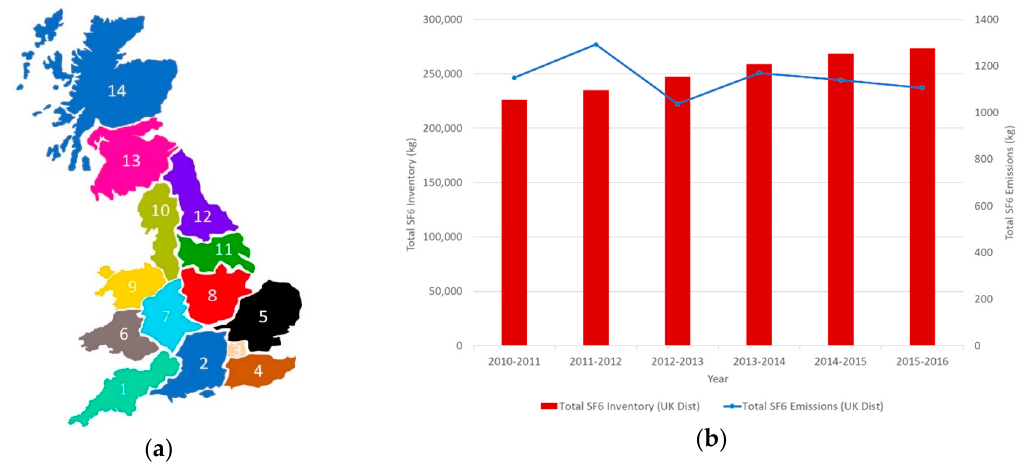
Figure 1. ( a ) Distribution network areas in Great Britain; and ( b ) the total SF 6 inventory (kg) and emissions level (kg) of the electricity distribution network in Great Britain [13–48].